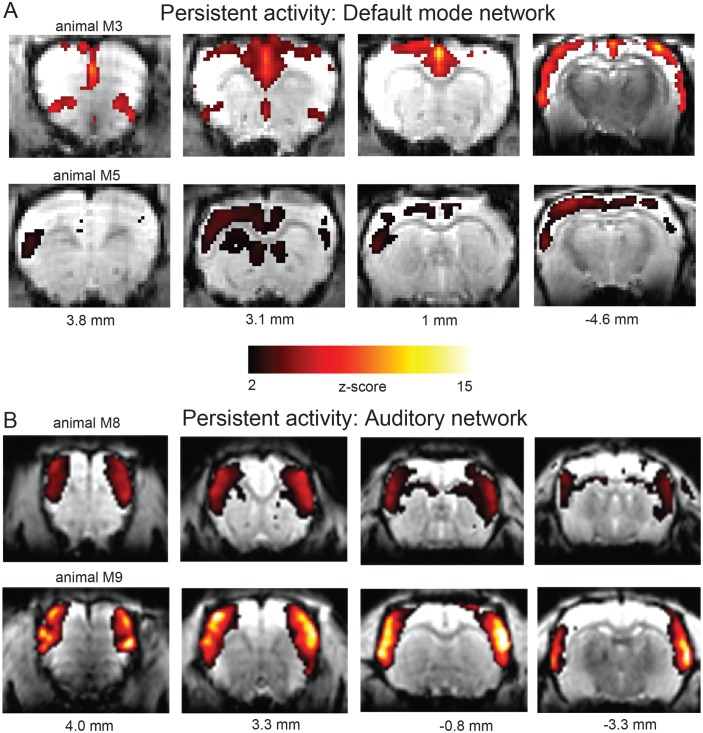
IC Analysis showing typical resting state networks during persistent activity.(A) ICA component showing canonical default mode network activation. The activation maps of two representative animals (out of 4) are depicted (labelled with AP coordinates in mm relative to bregma): At 3.8 mm activation of orbital and prelimbic cortex can be observed, at 3.0 and 1.0 mm cingulate cortex and at 4.6 mm temporal association cortex, posterior parietal cortex and retroslenial cortex. (B) Auditory cortical network component from the same animals as in (A). This component resembles activation of an auditory network involving sensorimotor (medial superior) and auditory (inferior parietal) cortices.